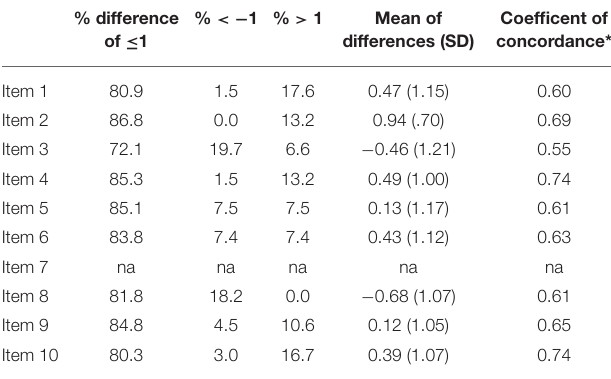
TABLE 3 | Percentage differences and coefficients of concordance between PCCP-AM items and expert rating instrument items. % difference of ≤